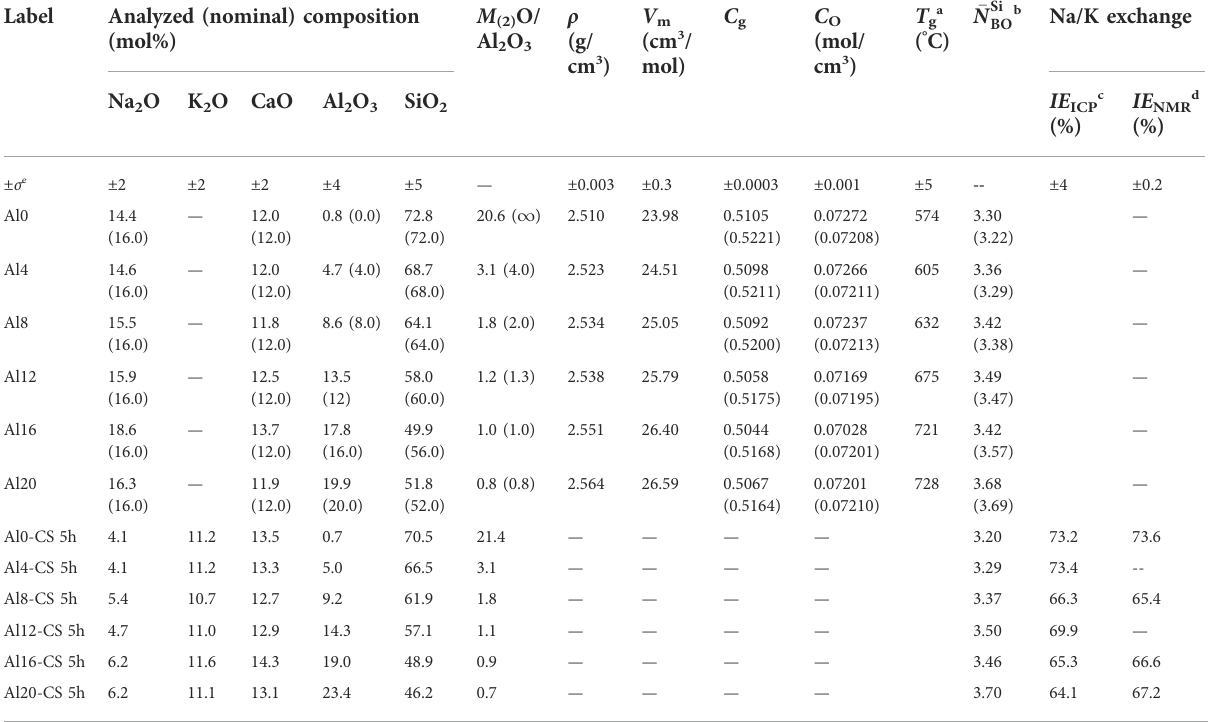
TABLE 1Analyzed and nominal glasscompositions (in brackets), density( ρ ),molarvolume ( V m ),compactness ( C g ), oxygen packing density ( C O ), glass transition temperature ( T g ), average network connectivity ( (cid:1) N Si BO ), and the K + -for-Na + exchange ratio d,e ( IE ). Parameters based on nominal composition are given in parentheses. All data originate from the glass powders (see Section 2.2.1), except for density ( ρ ) and thus indirectly also molar volume ( V m ), compactness ( C g ) that originate from the glass monoliths (see Section